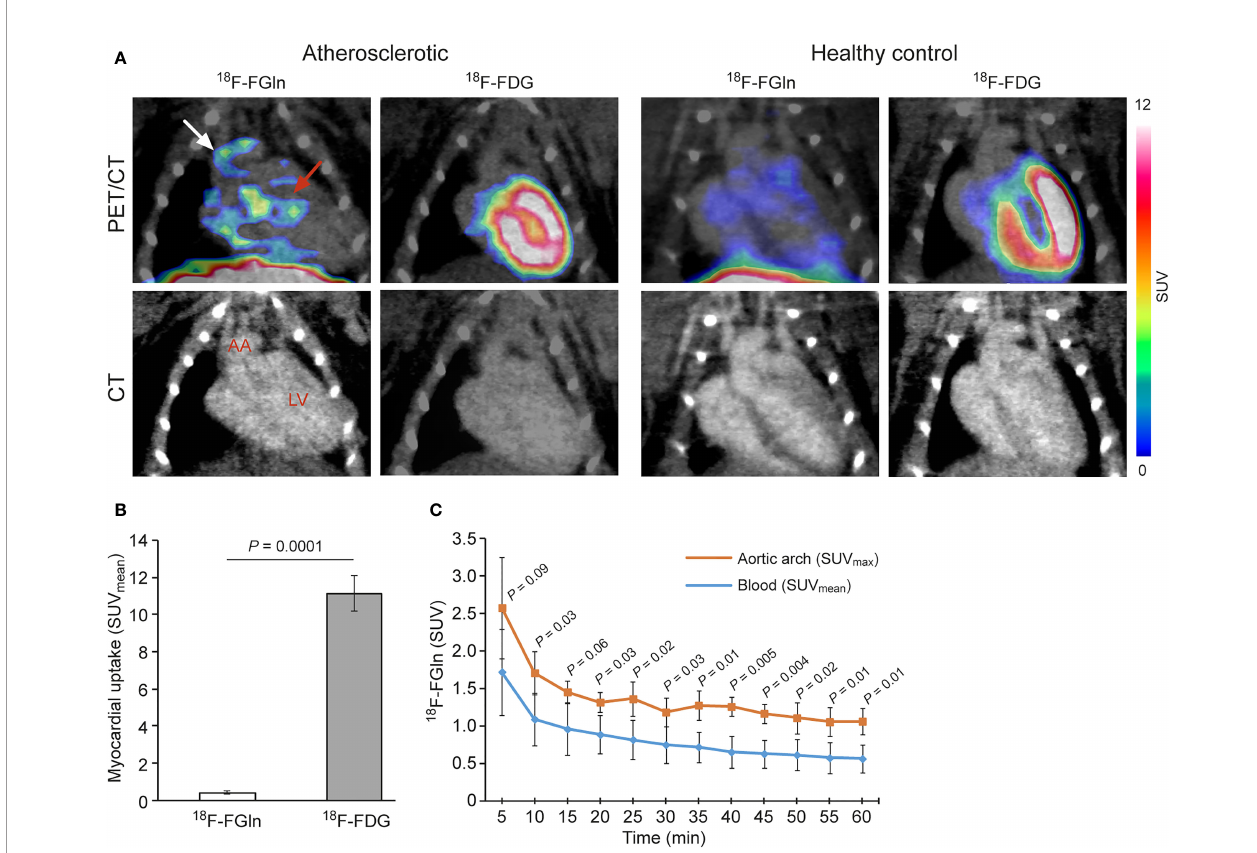
FIGURE 1 | (A) Representative coronal PET/CT images of atherosclerotic and control mice administered with 18 F-FGln or 18 F-FDG. White arrow indicate the aortic arch (AA), and pink arrow indicates the myocardium. LV, left ventricle. (B) PET quanti fi cation of the myocardium, showing a signi fi cant difference between the tracers. (C) 18 F-FGln time-activity curves in the AA and blood (vena cava) of atherosclerotic mice show a statistically signi fi cant difference ( n = 4). Values are presented as the mean ± SD ( n = 4). P -values were calculated using a two-tailed unpaired Student ’ s t